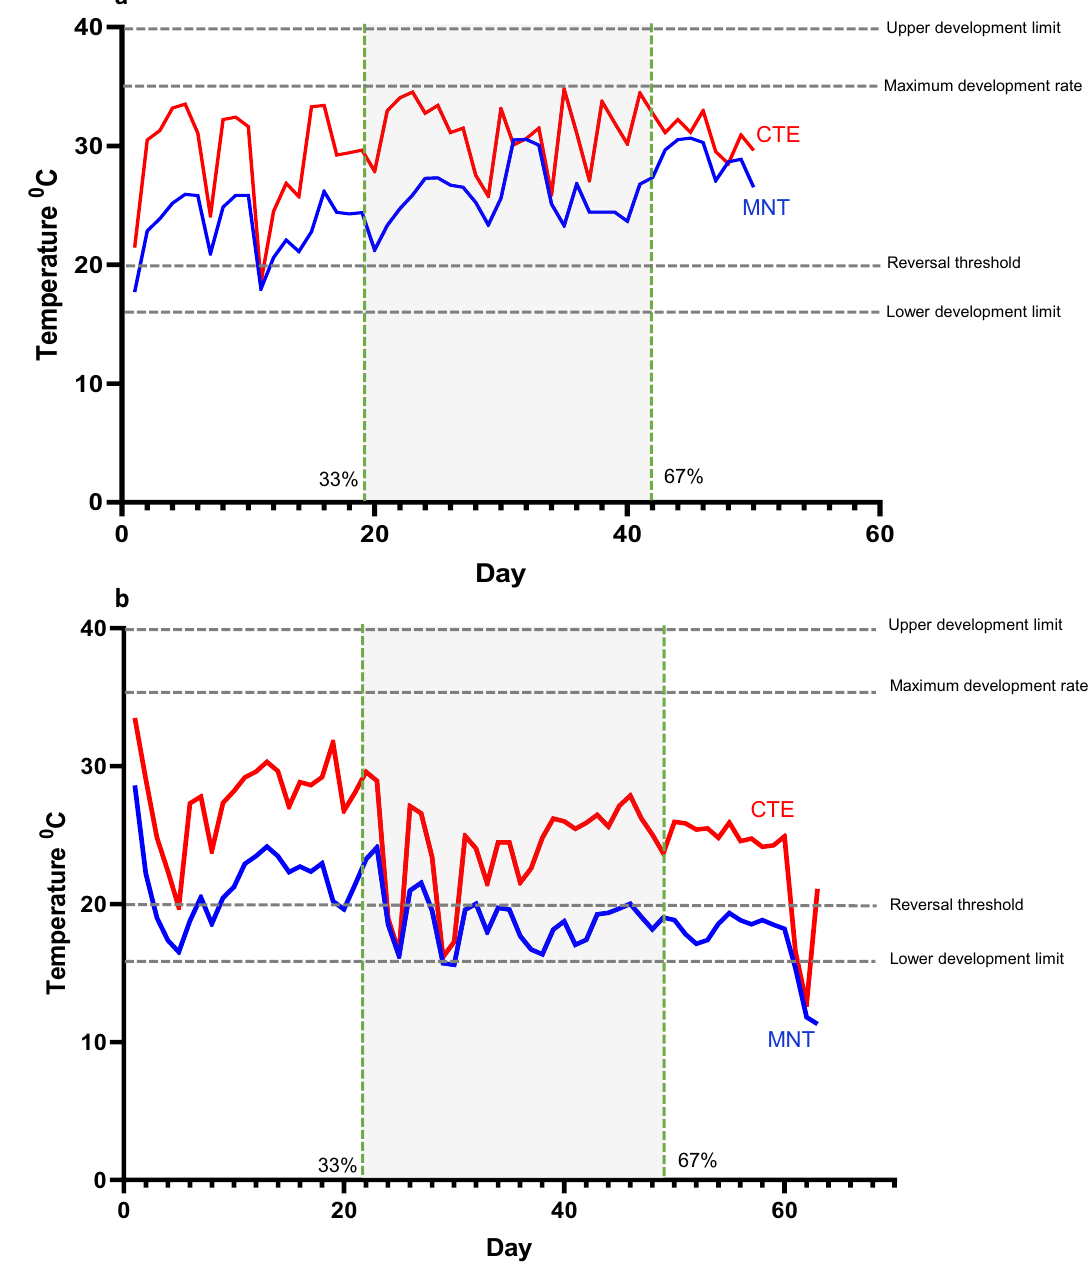
Figure 7. Temperature trace for the core of a nest of Bassiana duperreyi showing traces for the mean and the constant-temperature equivalent (CTE) for the Dallwitz-Higgins model 34,35 . ( a ). The nest produced only XYmale and XXfemale offspring, nest location: Dartmouth. ( b ). The nest produced XYmale, XXmale and XXfemale offspring, nest location: Mt Ginini. Shaded area: expecting to sex reversal happening during the incubation period. The threshold for sex determination (20 °C; Shine et al. 15 ) and the thermosensitive period lies between lower and upper limit of development. Note that the thermosensitive period does not correspond to the middle third of incubation, either in position or duration, owing to the nonstationary trend in temperatures with